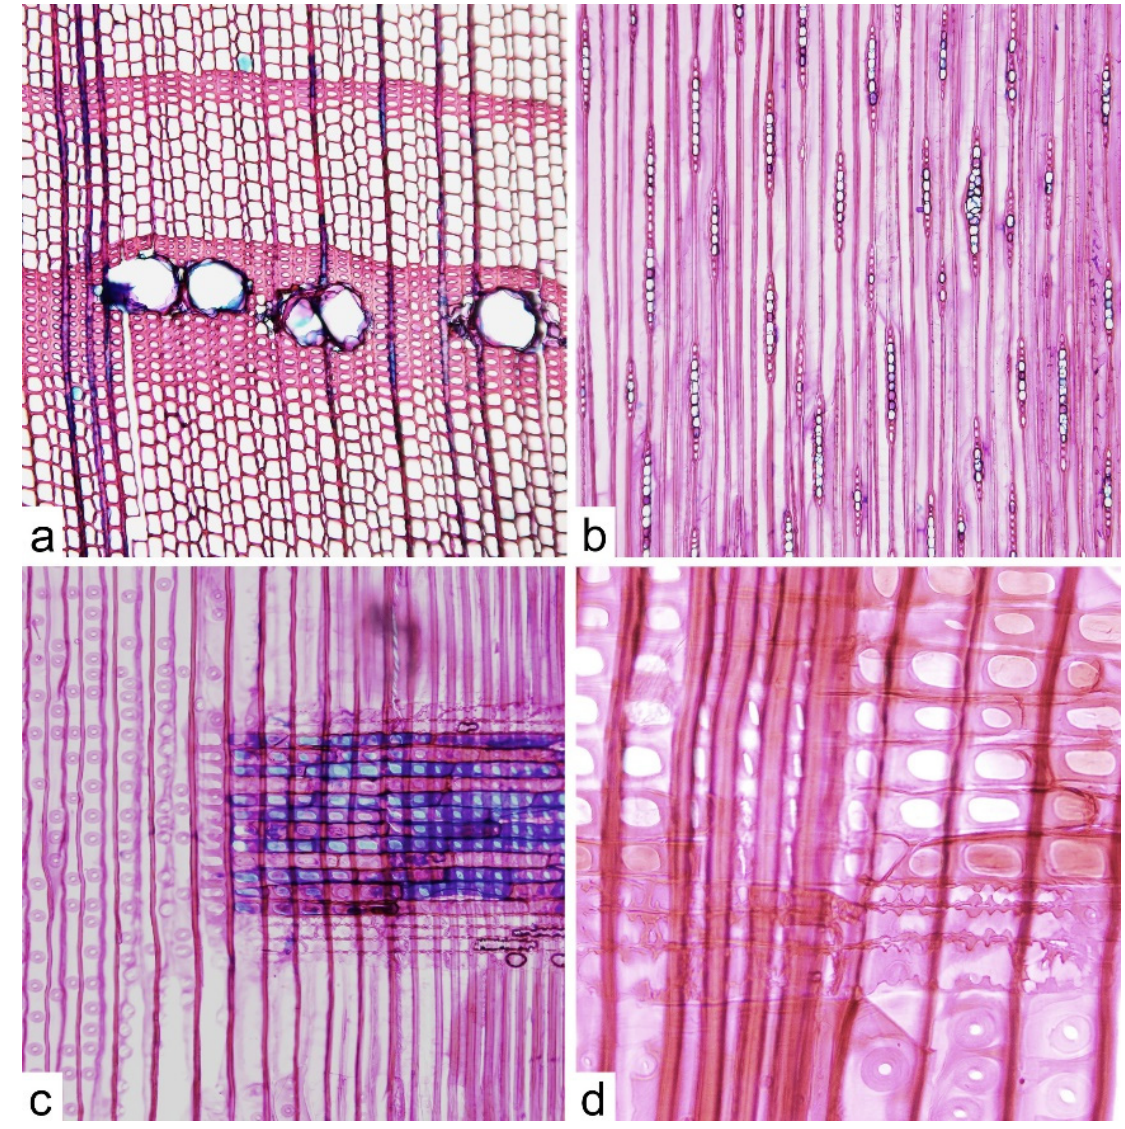
Figure 5. Black pine— Pinus nigra , sample no. ANM0007. Microscopic slides: ( a ) cross-section in which the well-defined growth rings and the quite rapid transition from early to latewood are visible, moreover, resin canals located in the latewood are visible; ( b ) tangential section—uniseriate and fusiform rays are visible; ( c ) radial section—heterogeneous ray is visible; ( d ) radial section—fragment of heterogeneous ray with window-like pits in cross fields is visible.